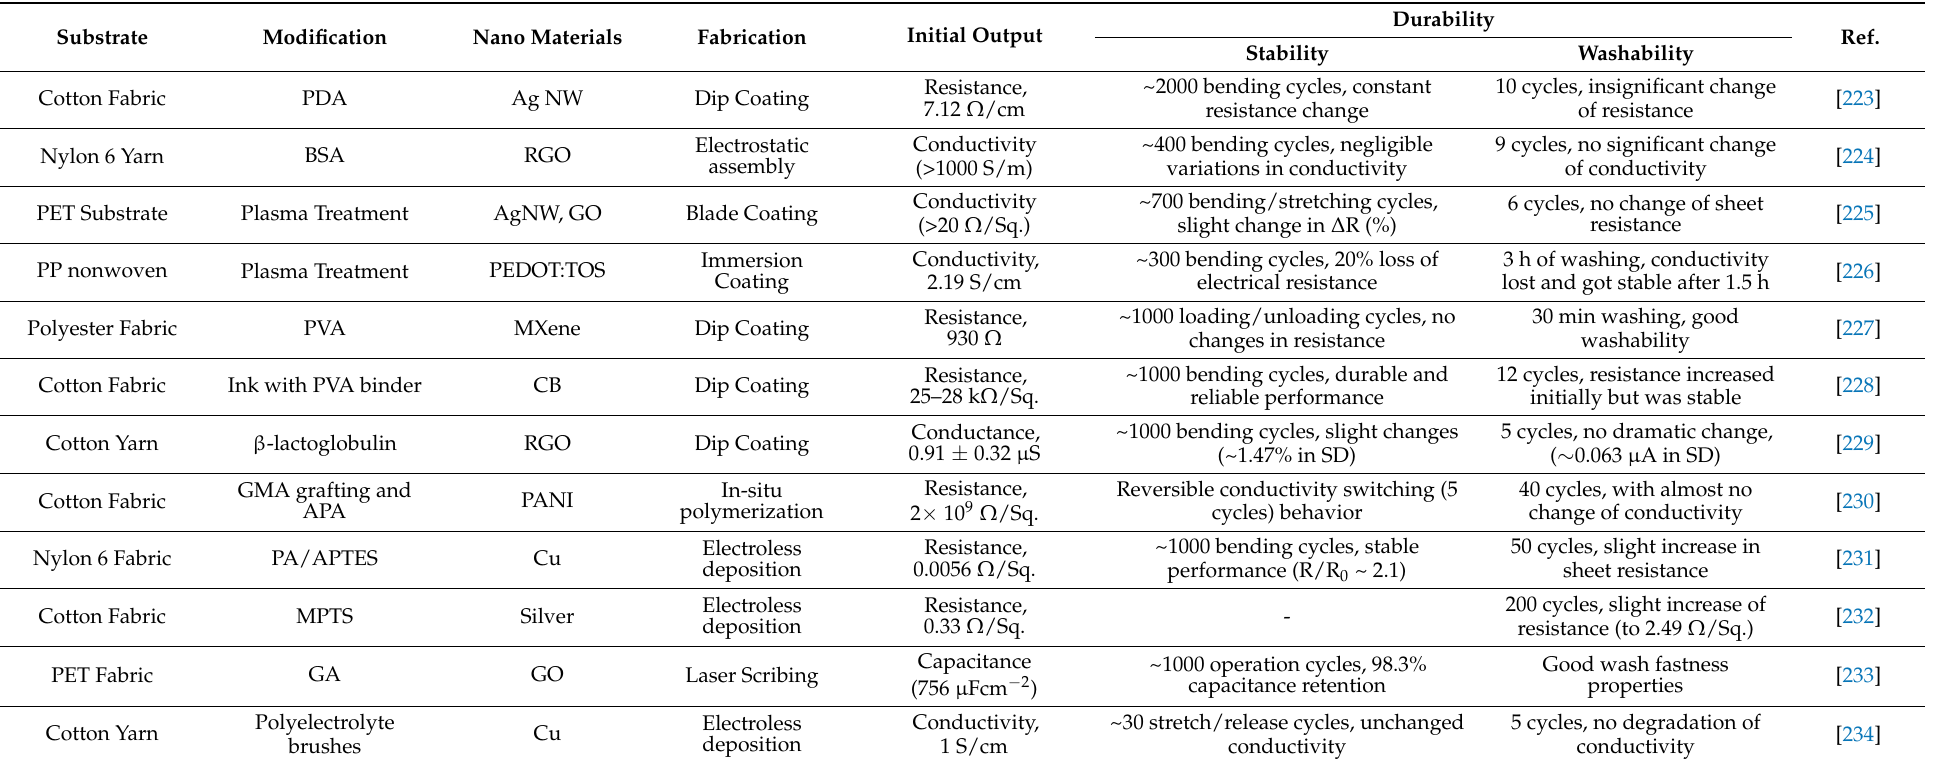
Table 3. Durability of e-textiles achieved by different surface modification